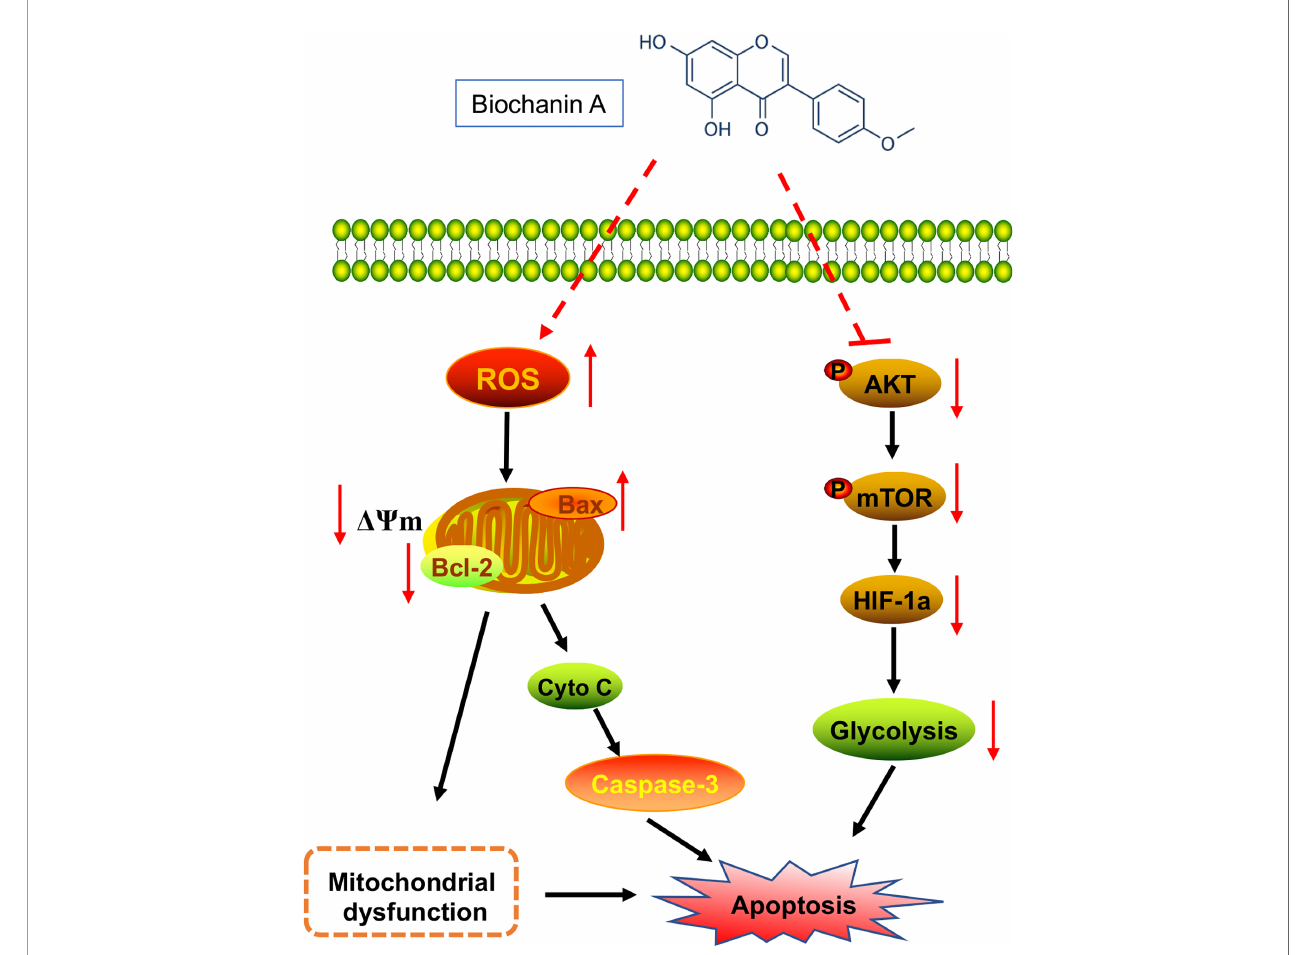
FIGURE 6 | Schematic of the proposed mechanism of BCA inhibits glioblastoma proliferation by inducing metabolic